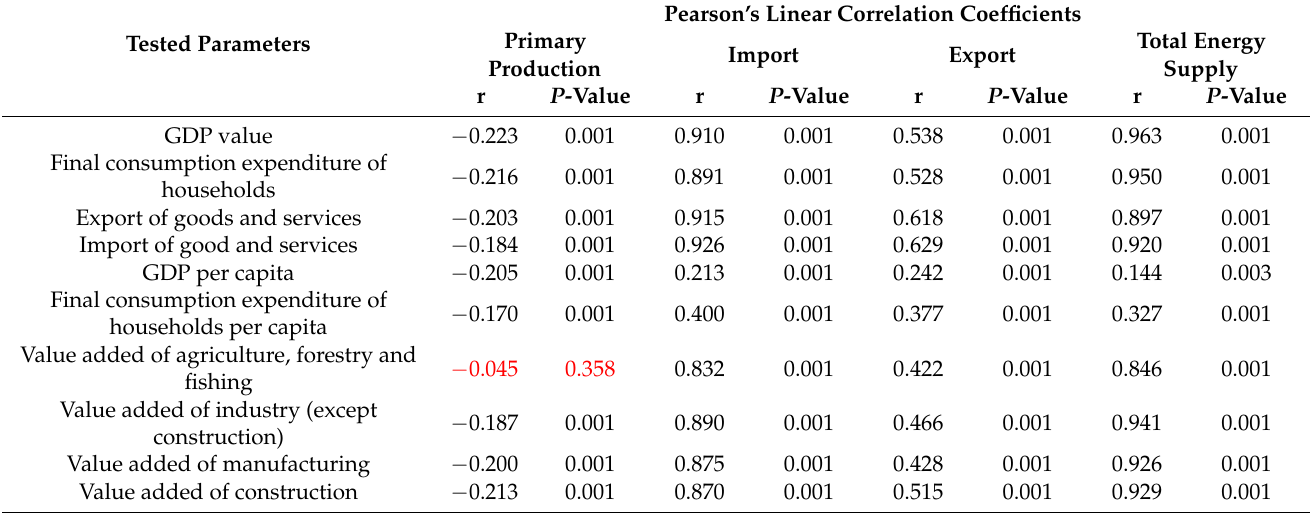
Table 3. Pearson’s linear correlation coefficients between energy parameters and the economic parameters.